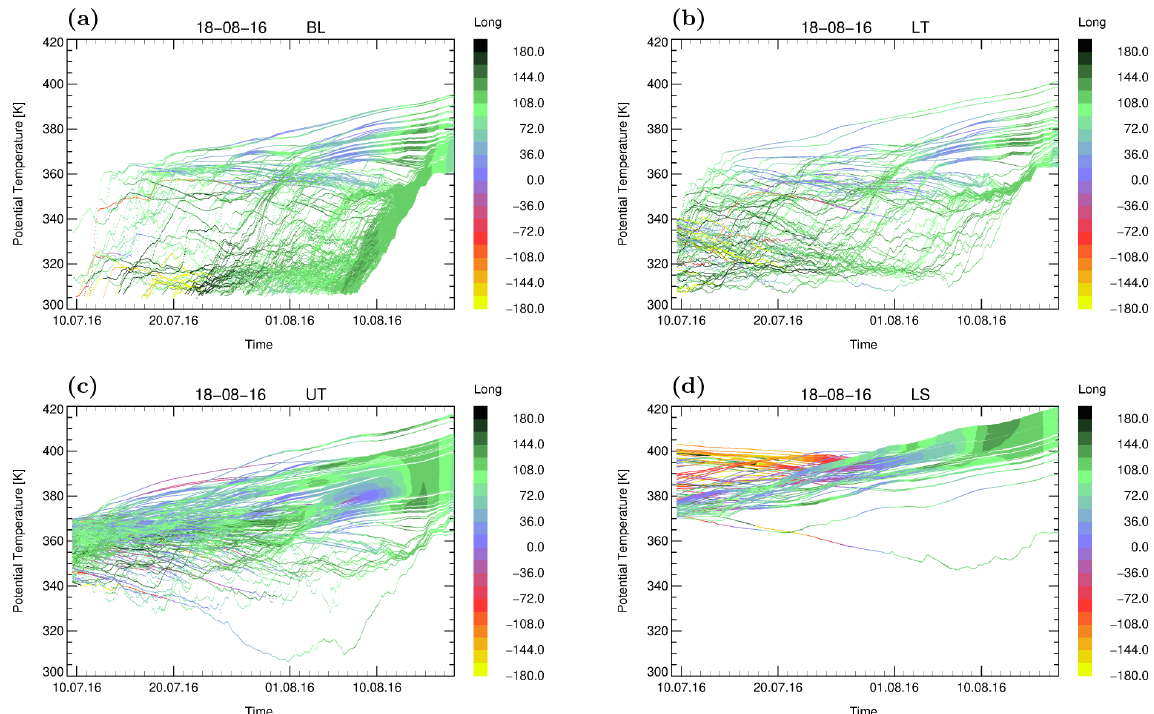
Figure 10. As Figs. 4 and 7 but for Case 3, the typhoon-influenced ATAL on 18 August 2016. The trajectories are calculated in a potential temperature range between 150 and 75hPa (362 to 422K).